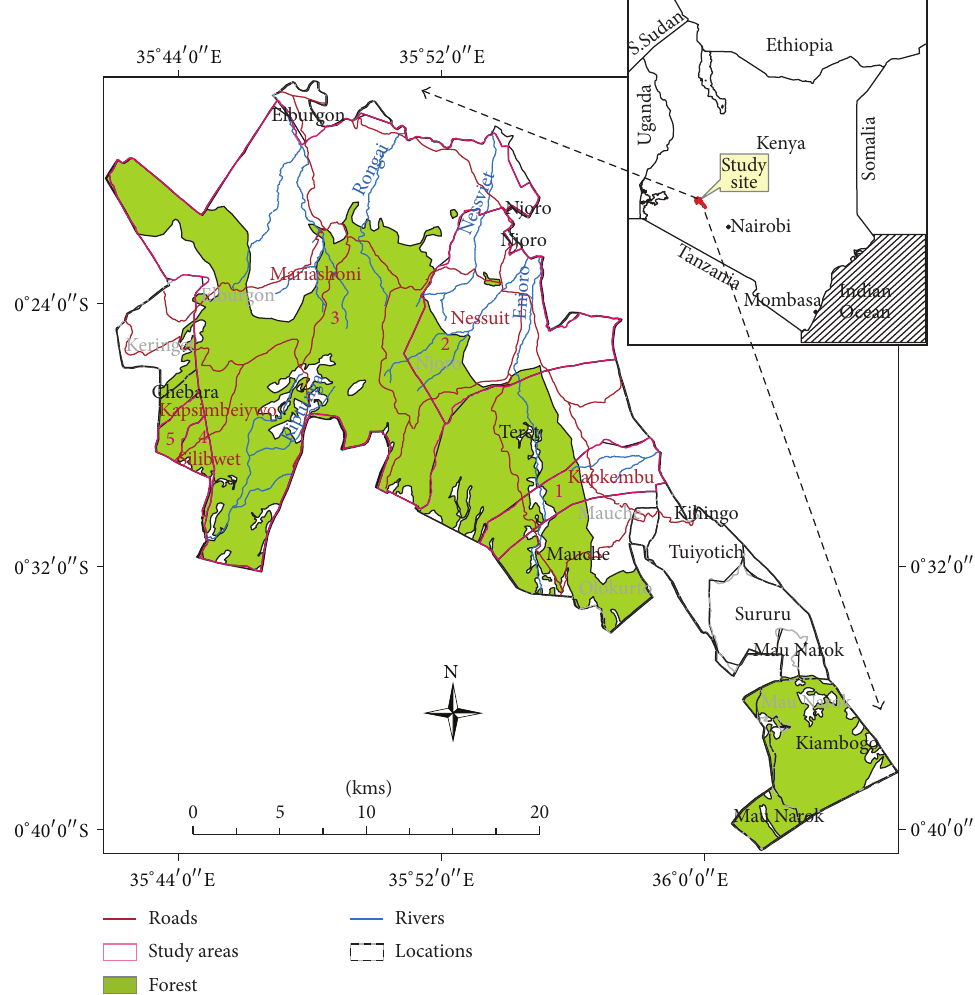
Figure 1: Map of the study area in East Mau forest in